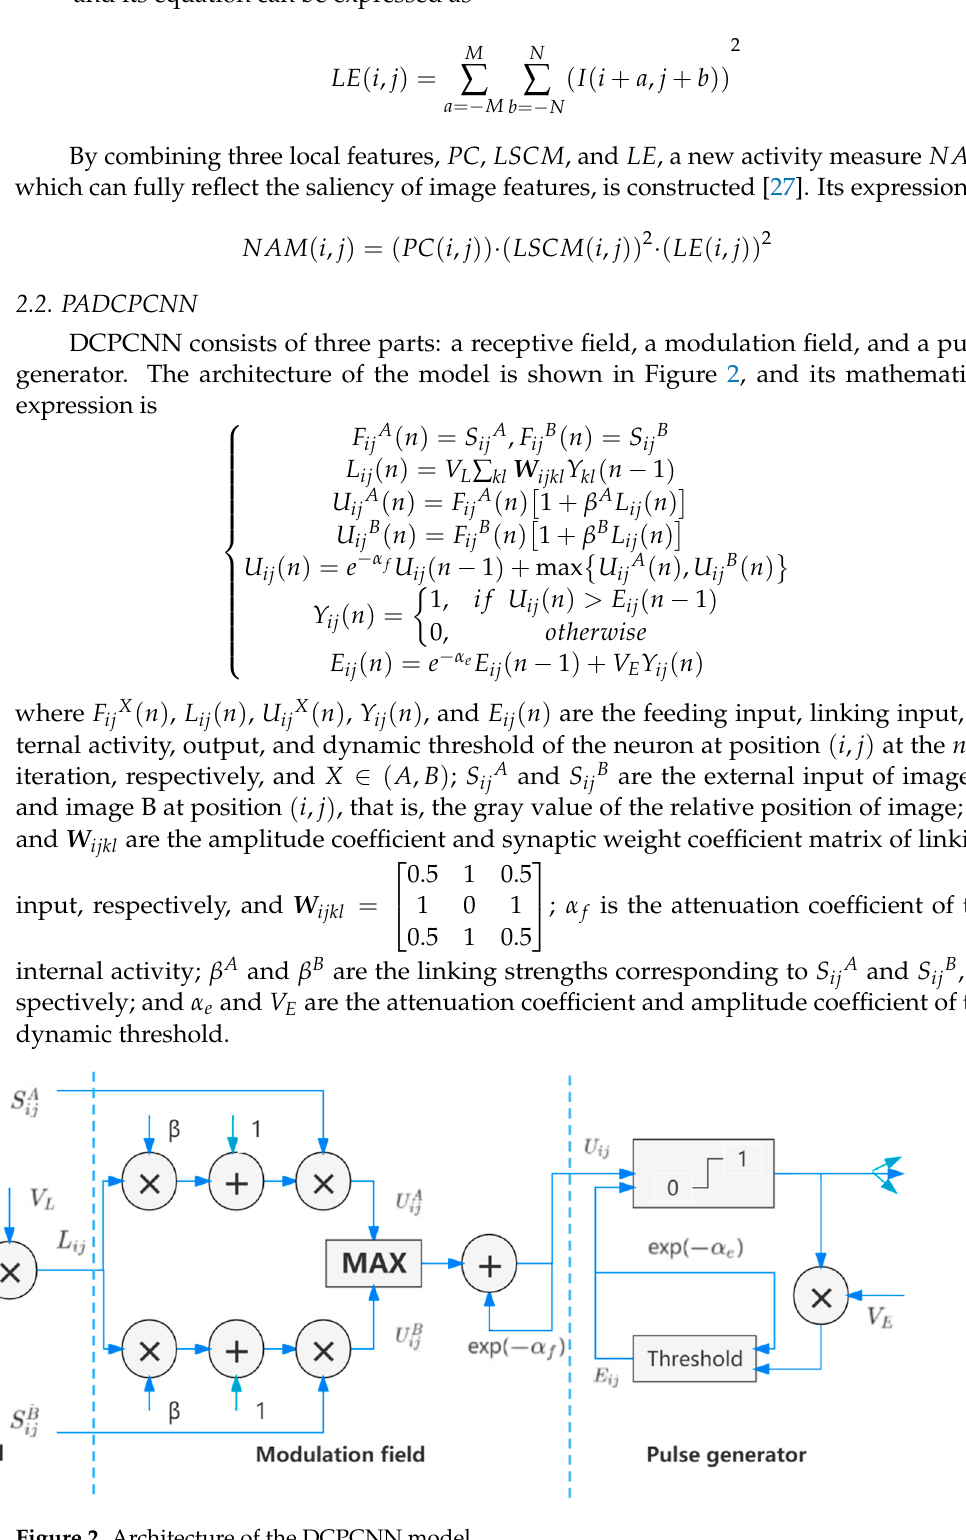
Figure 2. Architecture of the DCPCNN model.